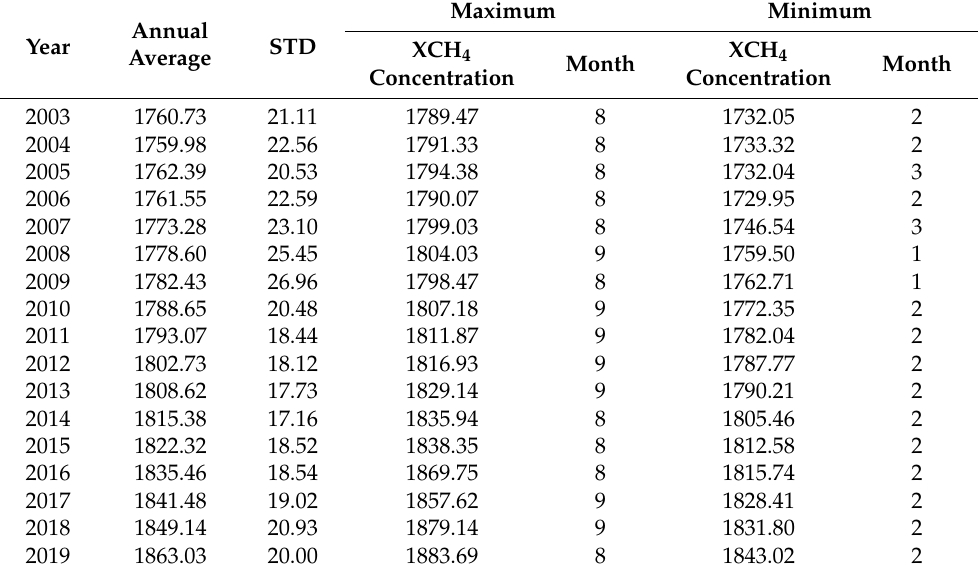
Table A1. Statistical characteristics of annual mean XCH 4 concentrations over China from 2001 to 2019 (unit: